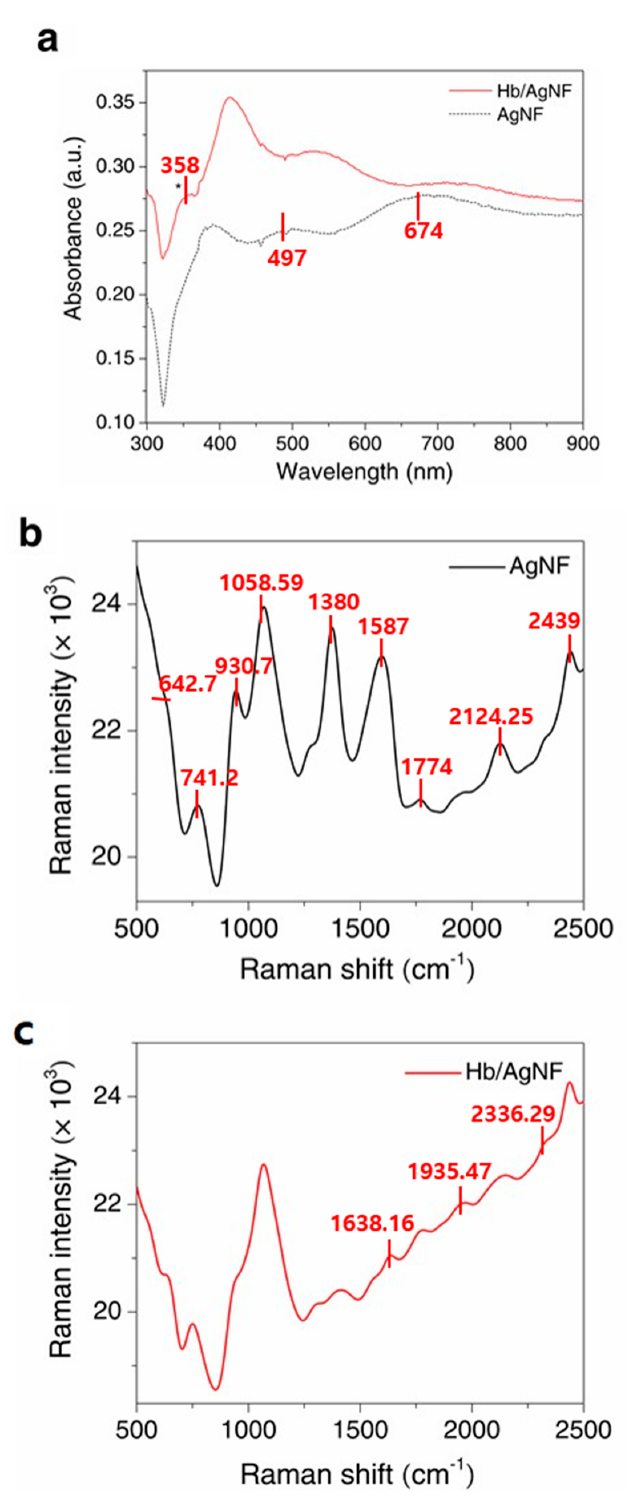
Figure 3. UV–Vis absorption spectra ( a ) and surface-enhanced Raman spectra ( b ) of AgNF/ITO and ( c ) Hb/AgNF/ITO substrates.